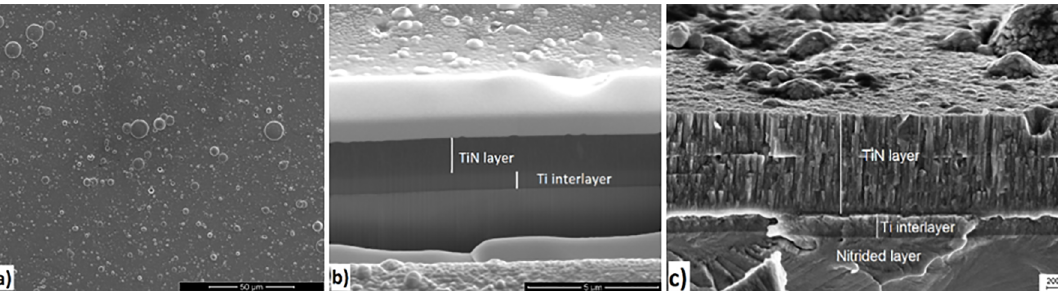
Figure 4. SEM image: a) surface film 650x, b) FIB-SEM thickness film: thick film10000x, c) columnar structure 50000x.